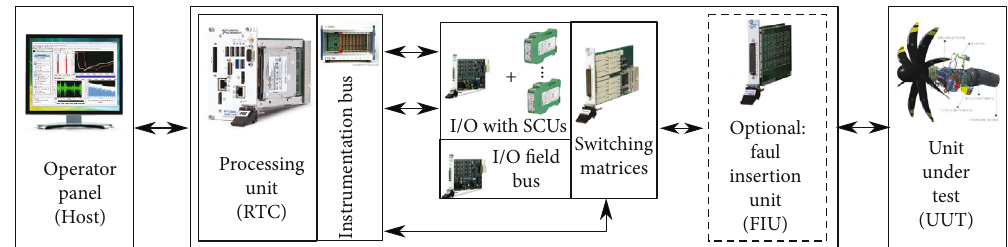
Figure 20: Integrated HIL veri fi cation